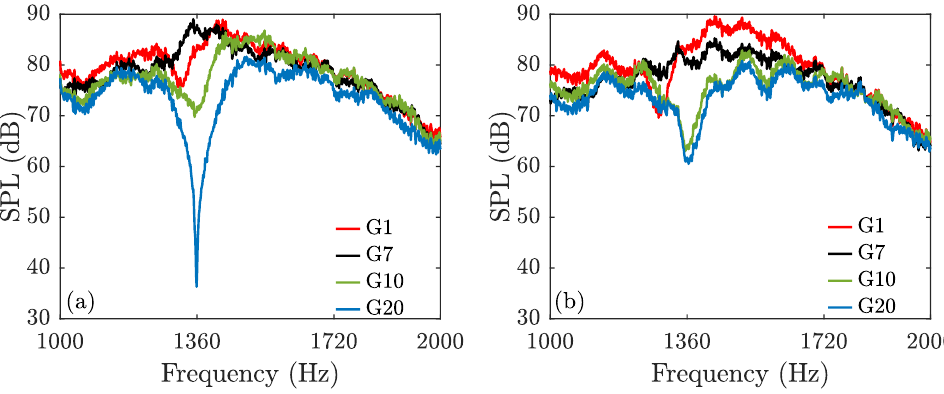
Figure 13. SPL of the acoustic signal from microphones G1 to G20. ( a ) s / λ = 0.25; ( b ) s / λ =